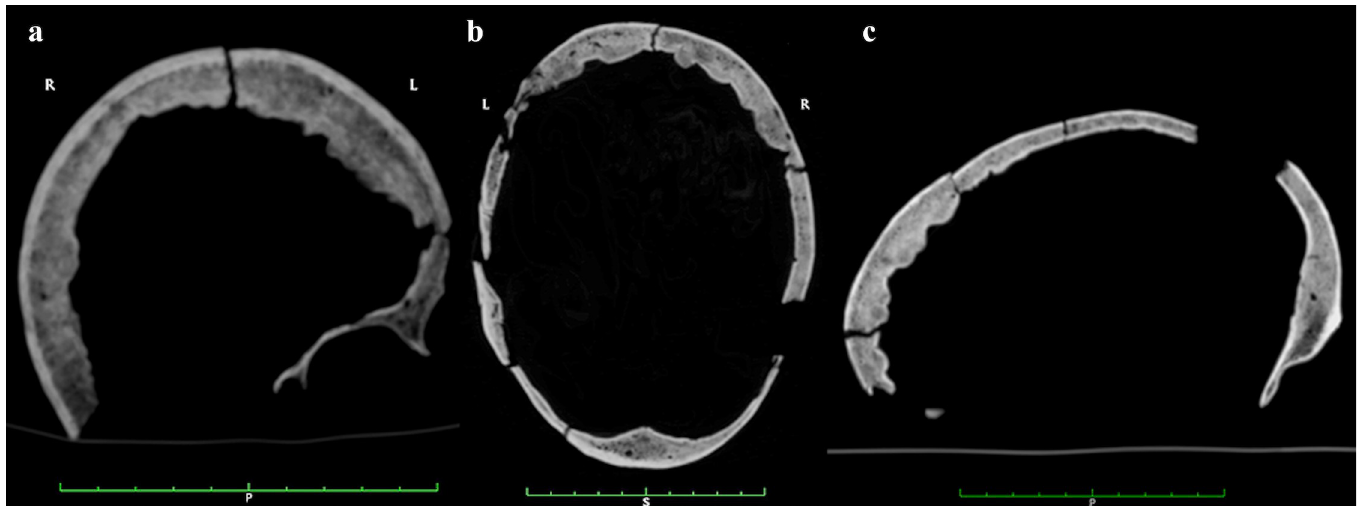
Fig 7. CT-scans in all projections: a. coronal view, b. axial view, c. sagittal view. The thickening and extent of the bony growth in the form of nodules protruding into the cranial cavity can be appreciated. A general thickening of the parietal and occipital bones can also be seen.